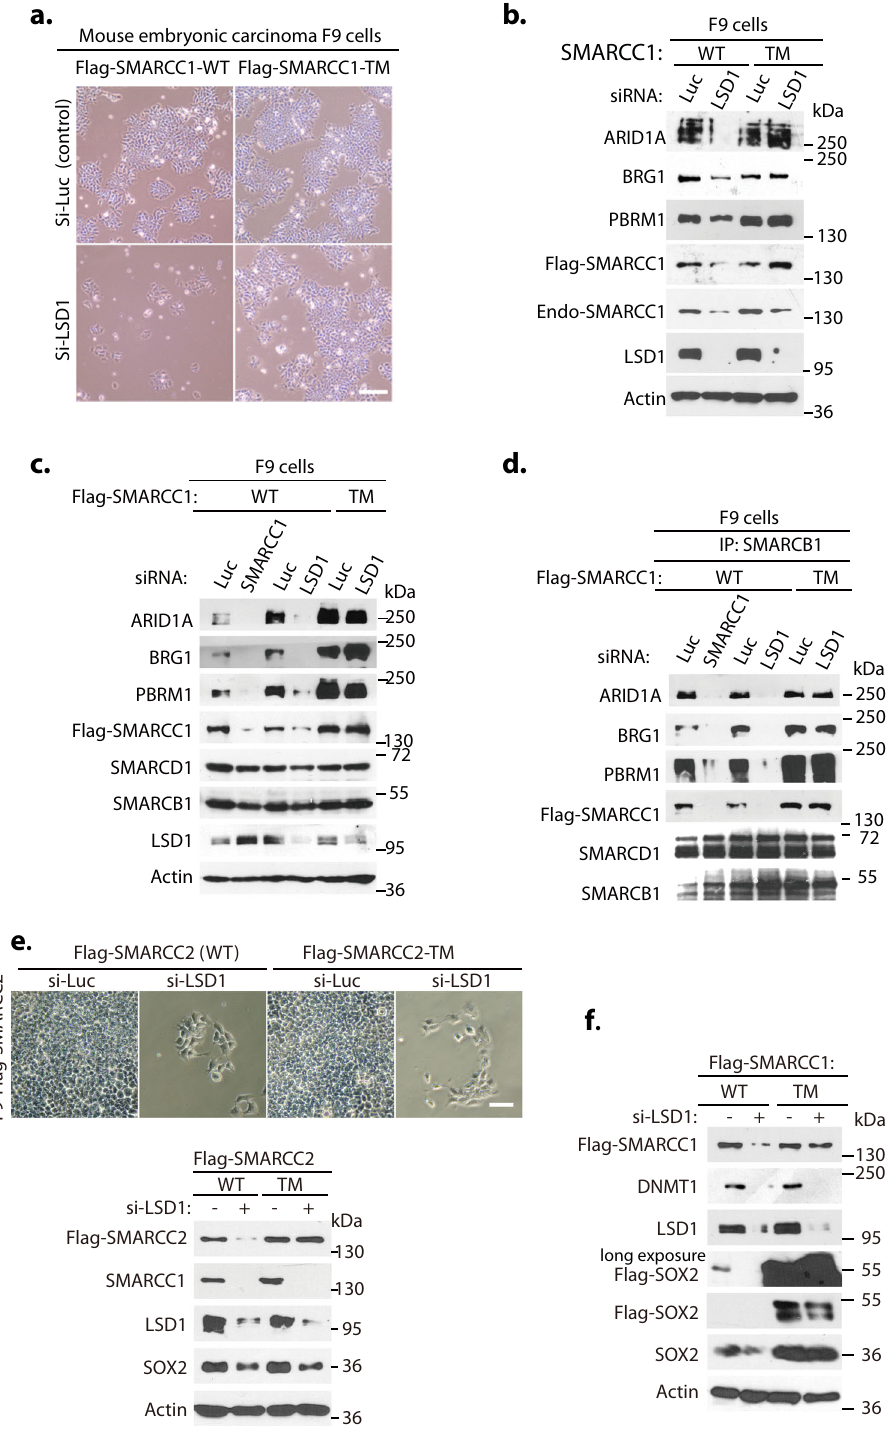
Fig. 6 | Mutations of SMARCC1 confer the resistance to LSD1 silencing in F9 embryonic carcinoma cells. a , b The wildtype and the K201R/K482R/K615R triple mutant of Flag-SMARCC1 were stably expressed in mouse F9 embryonic carcinoma cells. The cells were transfected with 50nM siRNAs of luciferase or LSD1 for 40h and cell images were acquired ( a ) and representation of three independent experiments is shown for mSWI/SNF proteins examined by Western blotting with respective antibodies ( b ). c , d F9 cells stably expressing the wildtype and the K201R/K482R/K615R triple mutant of Flag-SMARCC1 were transfected with 50nM of luciferase, SMARCC1, or LSD1 siRNAs for 40h as indicated. A set of lysates from a representation of three independent experiments is shown for direct Western blotting ( c ) and the other set for